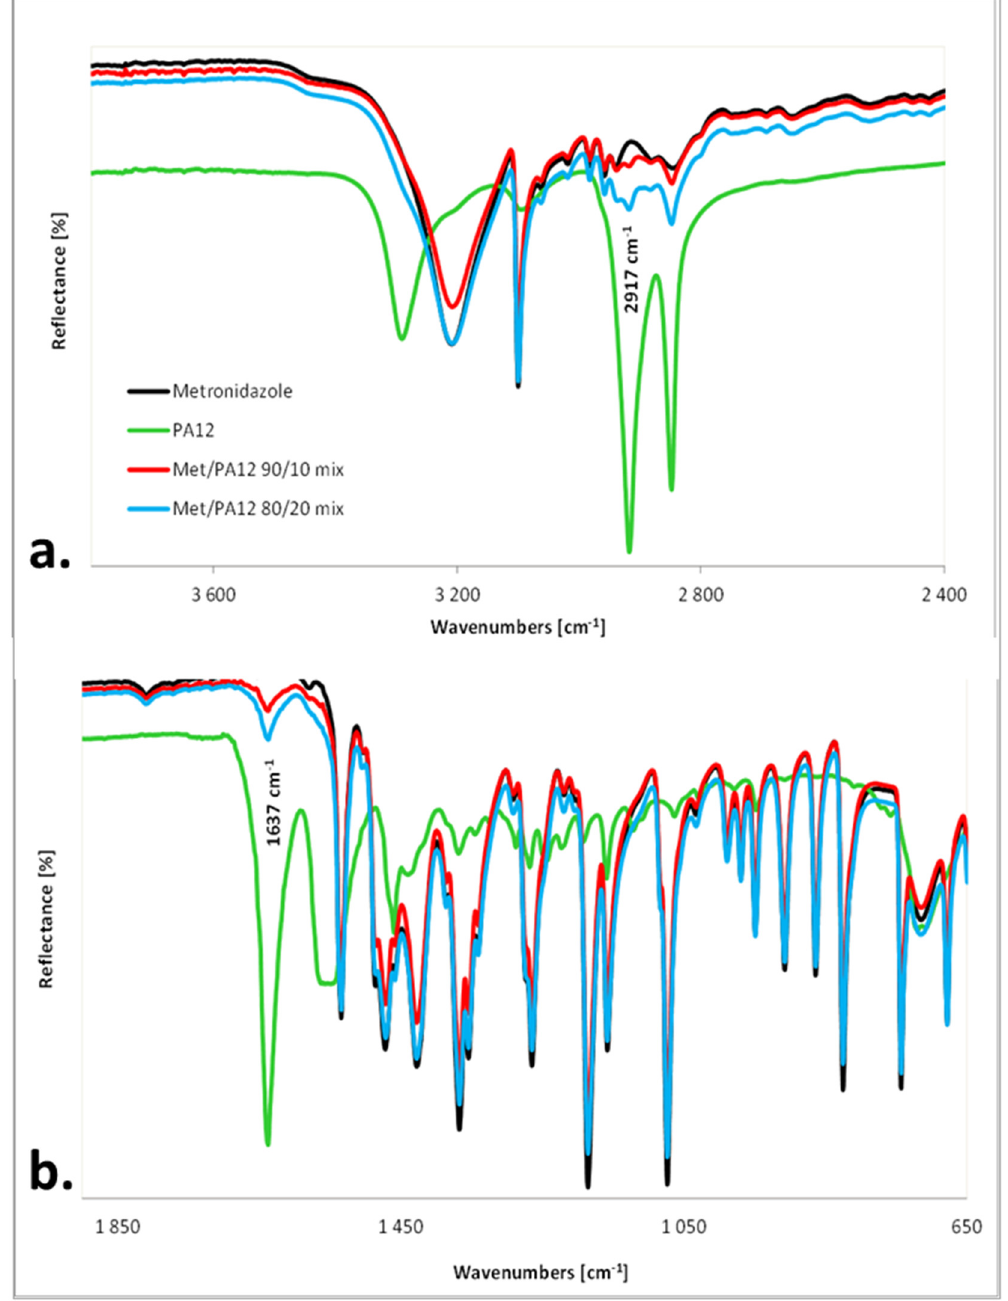
Figure 6. IR-ATR spectra of the pure components and physical mixtures of powders ( a ) in the range of 3700–2400 cm − 1 ; ( b ) in the range of 1850–650 cm − 1 .